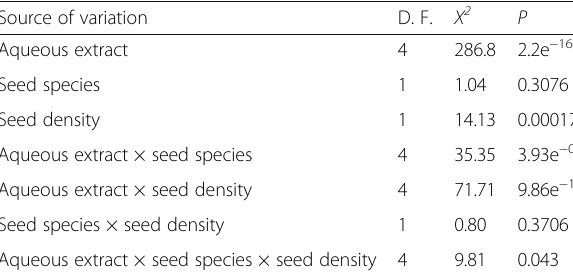
Table 1 Degrees of freedom (D. F.), χ 2 and P -value of generalized a linear mixed-effects model testing the effects of seed density, species ( Ipomoea murucoides , I. pauciflora ), and type of aqueous extract (seed extract of I . murucoides , seed extract of I. pauciflora , and water) on seed germination of I